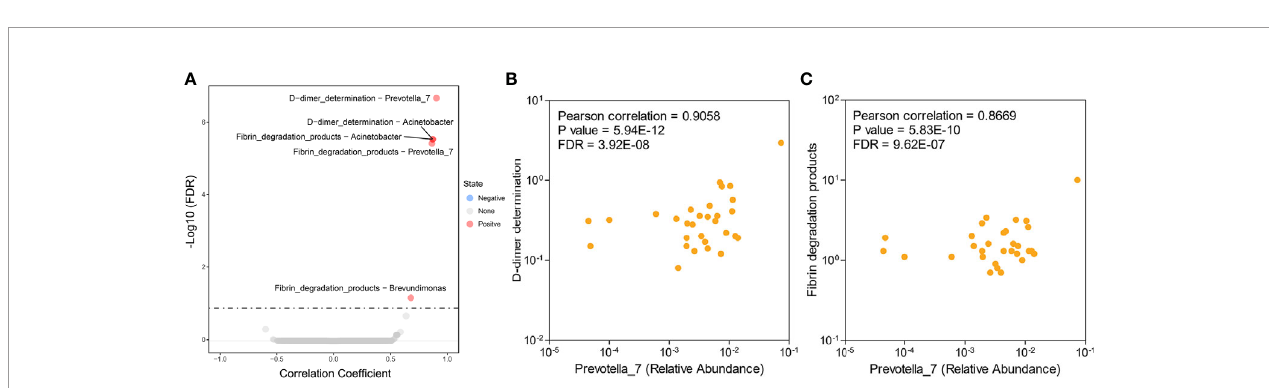
FIGURE 3 | Associations between endometrial microbiota and hematological indicators in patients with EC. (A) Differential level of the microbe-associated hematological indicator from 30 EC samples. (B, C) Scatter plots of two Prevotella -related hematological indicators: Prevotella -D-dimer (B) and Prevotella - fi brin degradation products (C) . Each point represents a